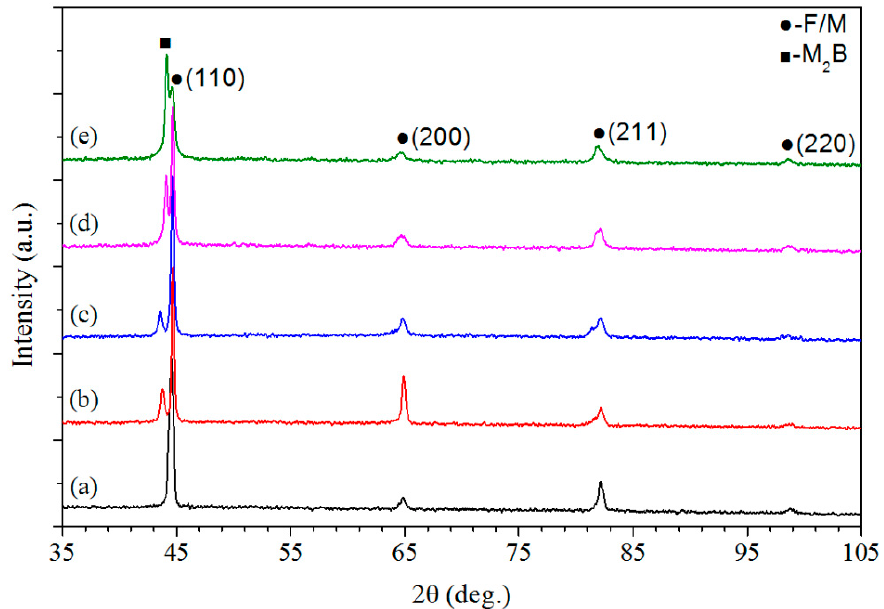
Figure 3. X-ray diffraction patterns of deposited alloys with different weight fractions of Fe–Cr–B–Si–Mo powder: ( a ) 0%, ( b ) 6.25%, ( c ) 12.5%, ( d ) 25%, and ( e ) 100%, respectively.